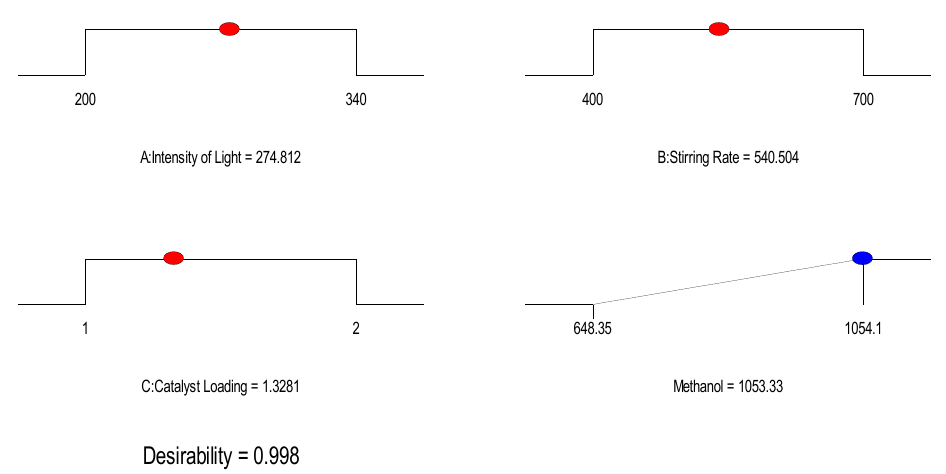
Figure 16. Ramp view diagram for optimization.